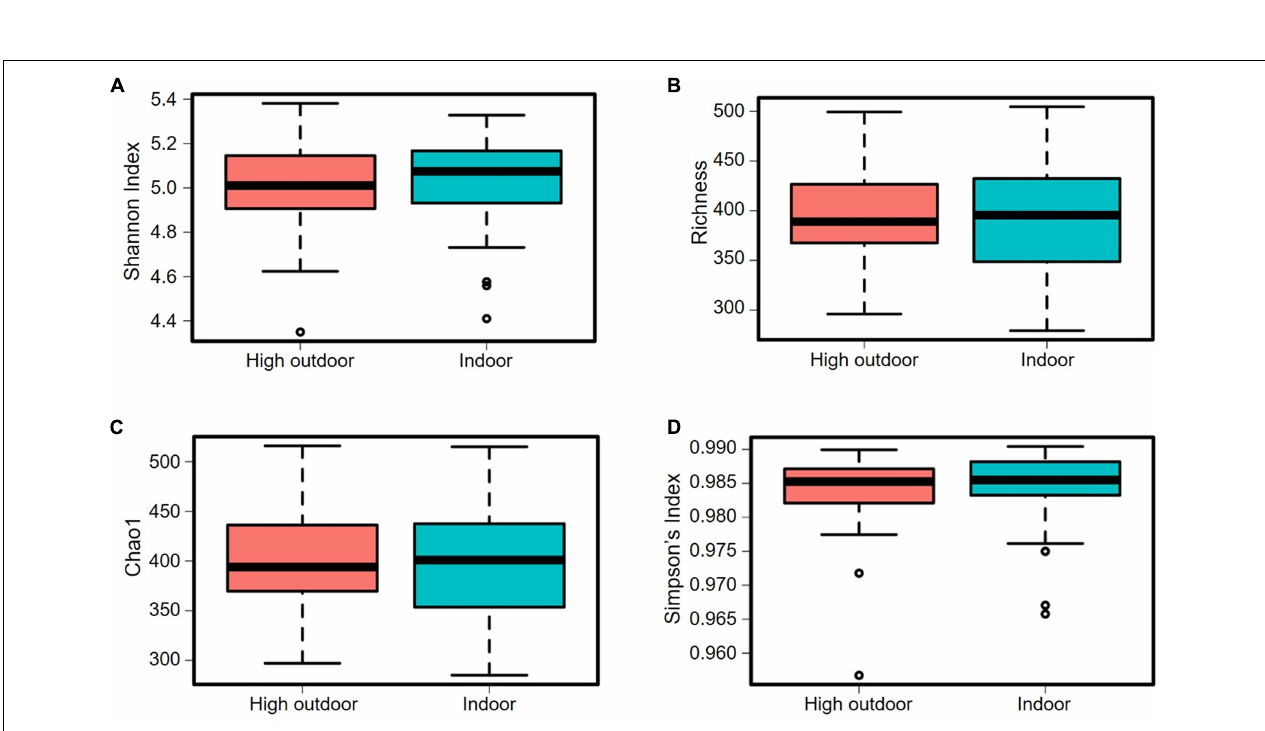
FIGURE 9 | Microbial diversity (alpha-diversity) of cecal microbiota of free-range hens at 65 weeks of age from different ranging patterns (high outdoor, indoor) at ASV level. (A) Shannon index, P = 0.74; (B) Richness, P = 0.66; (C) Chao1, P = 0.66; (D) Simpson’s index, P = 0.54.